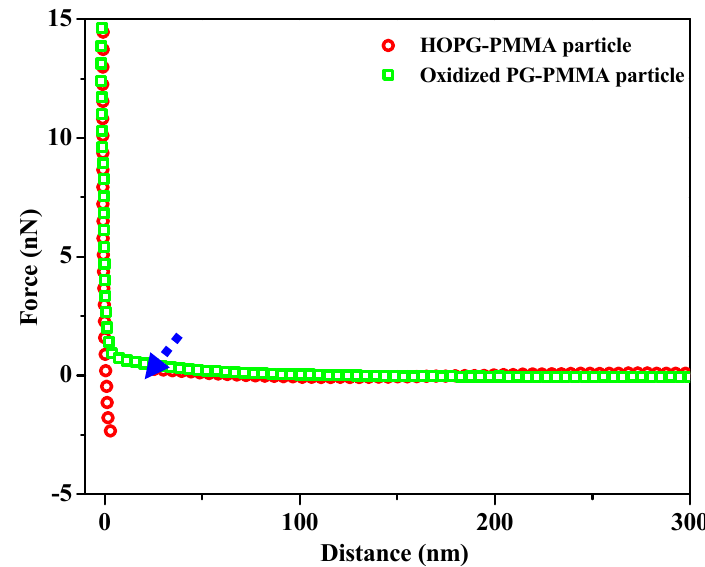
Figure 7. Force between PMMA colloid probe and HOPG/oxidized PG. Only approach force curves were shown.